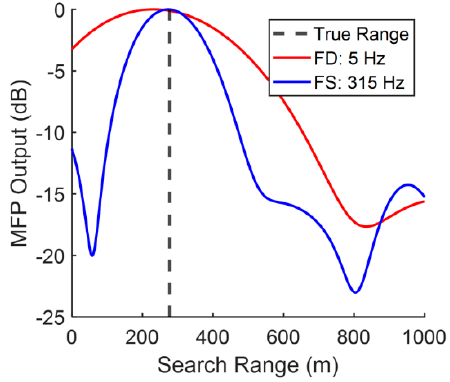
Figure 10. Matched-field processing results as in Figure 9 for frequencies outside of the signal band- width. The vertical dashed black line indicates the true source range. The frequency-difference autoproduct at 5 Hz is shown in red, while the frequency-sum autoproduct at 315 Hz is shown in blue.